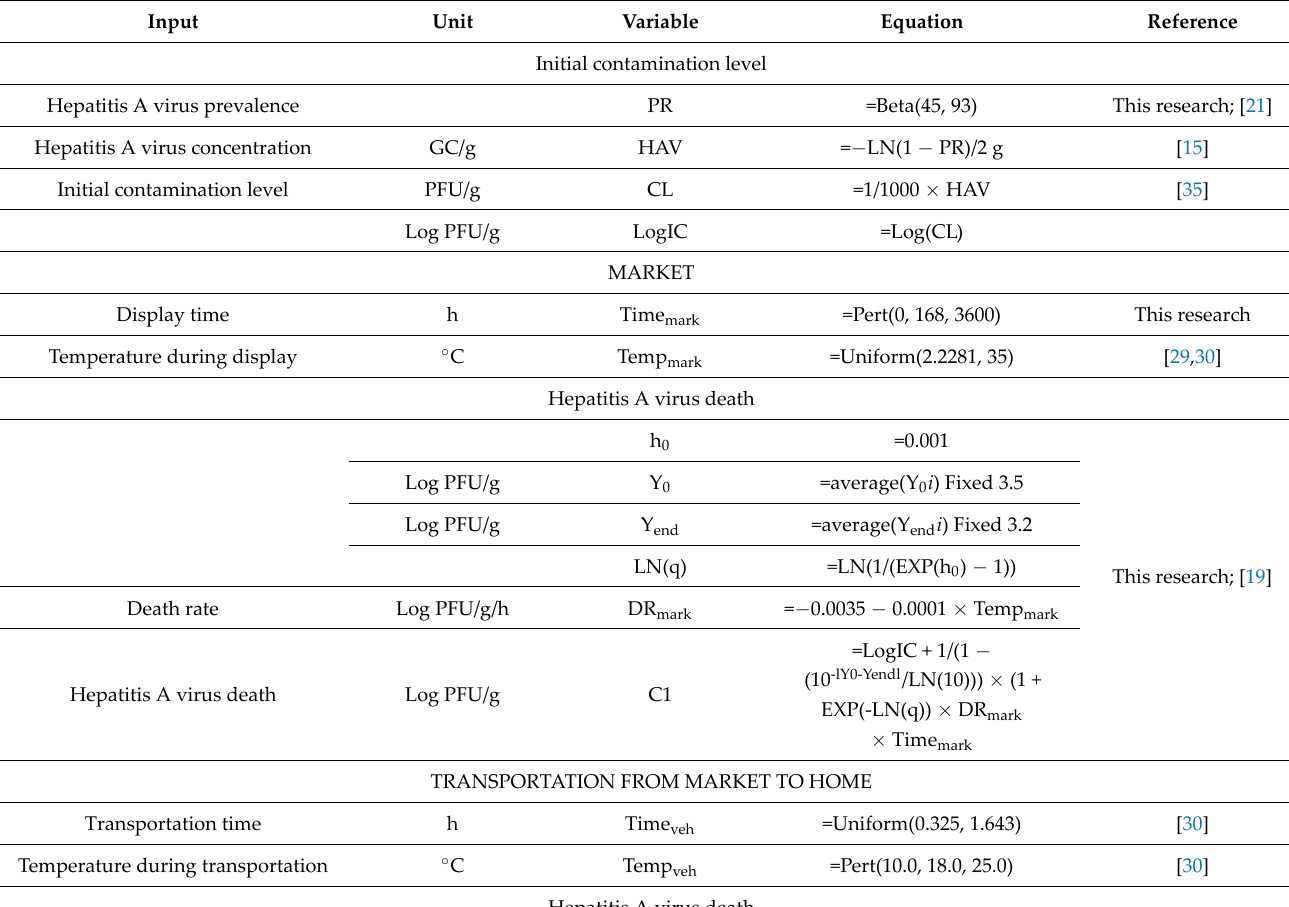
Table 2. Simulation model for estimating the risk of hepatitis A virus in the fermented clams with